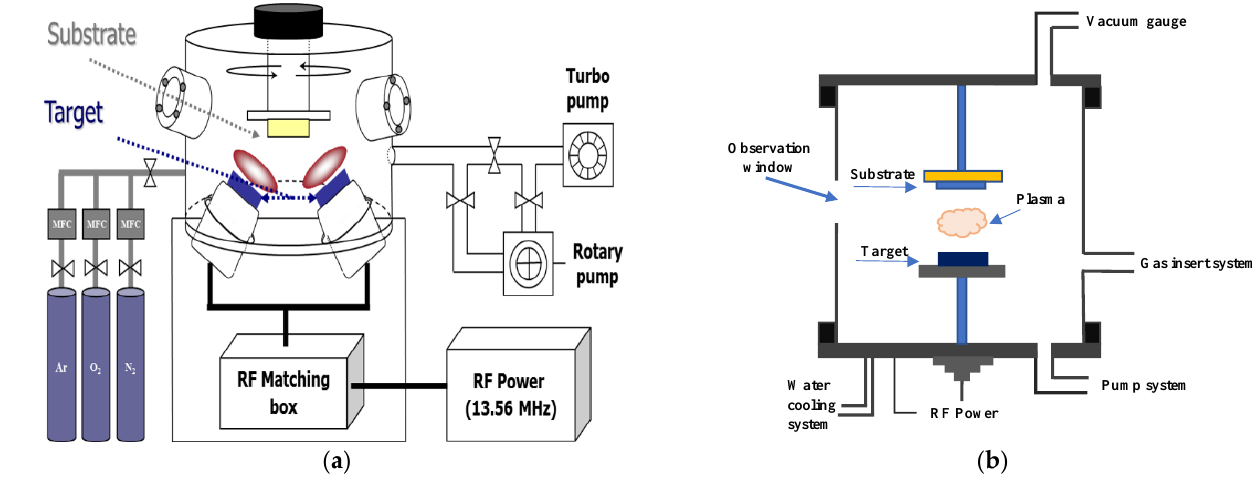
Figure 3. Schematic of ( a ) the PECVD and ( b ) RF magnetron sputtering system. Table 1. Conditions for growing CNW via PECVD.